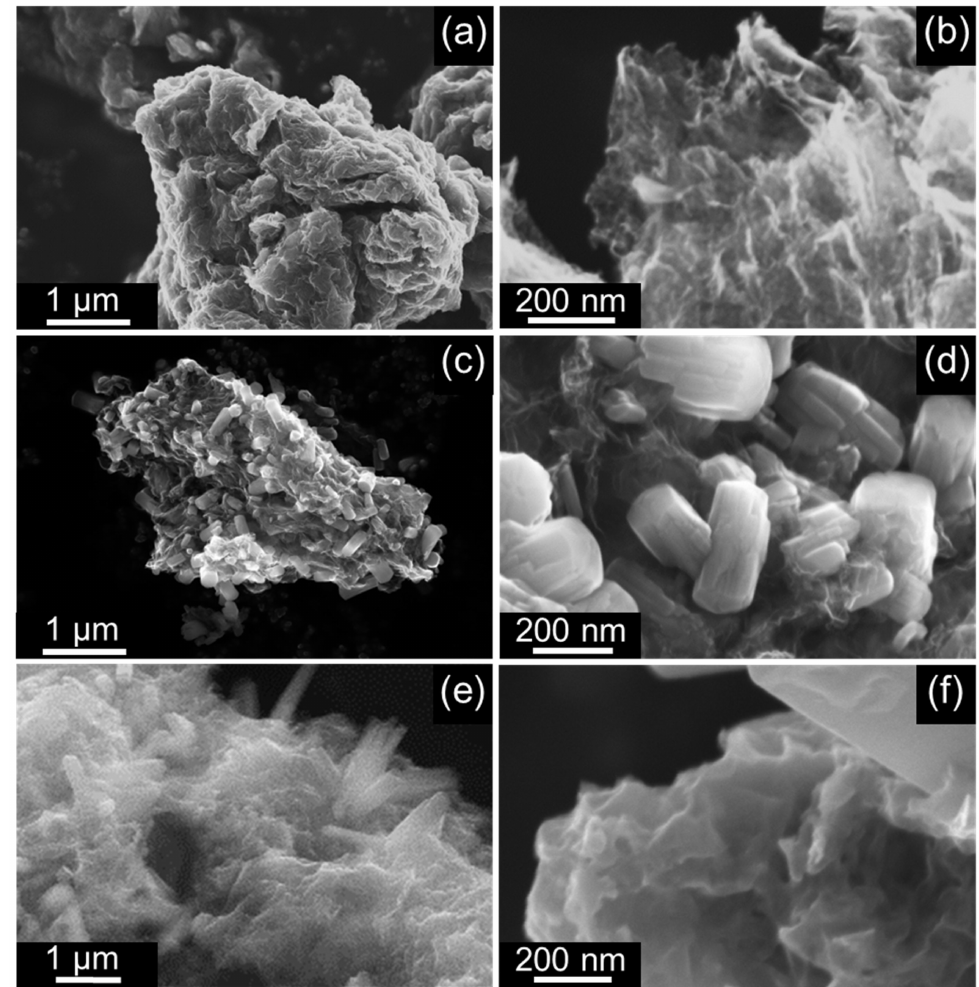
Figure 2. SEM images of GeO 2 -rGO-80 ( a , b ), Ge 3 N 4 -rGO-80 ( c , d ), and GeP-rGO-80 ( e , f ). Table 1. Elemental analysis of GeO 2 -rGO, Ge 3 N 4 -rGO, and GeP-rGO materials. Material C, wt.% (by CHN) N, wt.% (by CHN) Ge:P, at:at (by